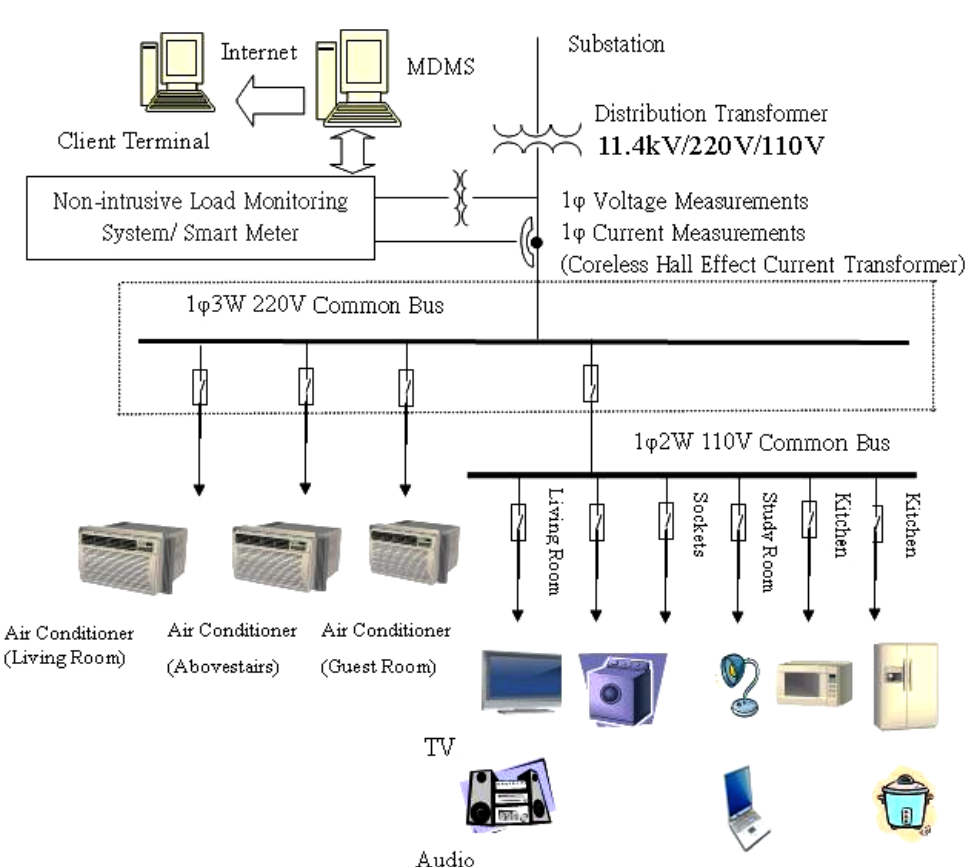
Figure 1. Data collection and load identification system for an NILM